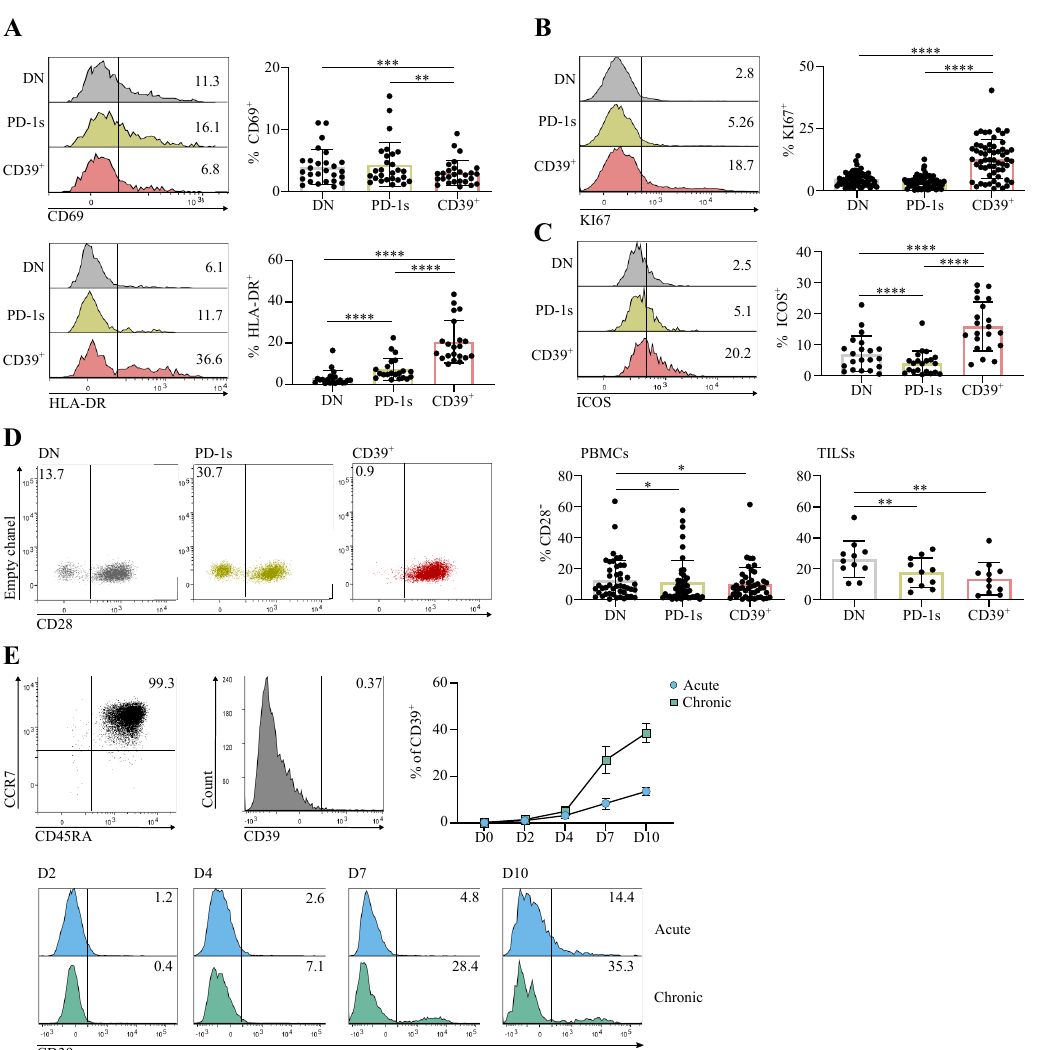
Figure 2. The circulating PD-1+CD39+ CD4 T-Cell subpopulation is enriched in activated and proliferating cells that were at an early differentiation stage. ( A – D ) CD4 T cells sorted ex vivo from PBMCs or from tumor cell suspensions (TILs) of CC or HNSCC patients at diagnosis were stained and analyzed by flow cytometry. Expression of the indicated markers is shown in the PD-1 - CD39 - (DN), PD-1 + CD39 - (PD-1s), and CD39 + populations gated in memory Tconv. Histograms show the expression of CD69 and HLA-DR ( A ), KI67 ( B ), and ICOS ( C ) in the indicated memory Tconv populations and data obtained for all patients are summarized (CD69 ( A ) n = 27; HLA-DR ( A ) n = 21; KI67 ( B ) n = 56; ICOS ( C ) n = 21). Dot plots ( D ) show the expression of CD28 in the indicated memory Tconv populations from PBMCs and the proportions of CD28 - cells in each memory Tconv population are summarized ( D ) for PBMCs ( n = 45) and TILs ( n = 11). ( E ) Naïve CD4 T cells (CD3 + CD4 + CD45RA + CCR7 + ), sorted by flow cytometry from healthy donor PBMCs, were stimulated in vitro with anti-CD3 and anti-CD28 mAbs in acute or chronic conditions. CD39 expression was assessed in cultures on days 2, 4, 7, and 10 by flow cytometry following staining with specific mAbs. The dot plot and the histogram in the upper panel show the purity of the sorted naïve population and the absence of CD39 expression, respectively. Histograms in the lower panel show the CD39 expression in D2 to D10 acute and chronic stimulation cultures from 1 HD. Data obtained for all HDs ( n = 3) are shown as the mean ± SD of CD39 expression at all timepoints for the two stimulation conditions.